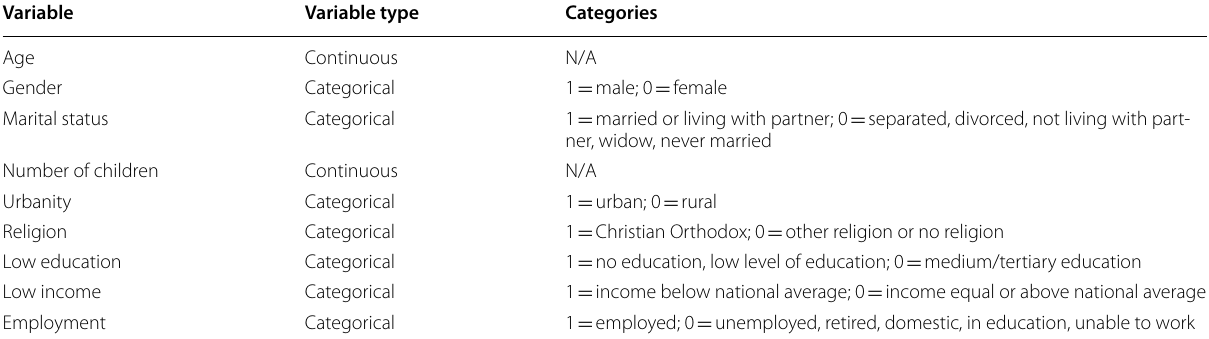
Table 1 Variables considered for use in the empirical analyses Variable Variable type